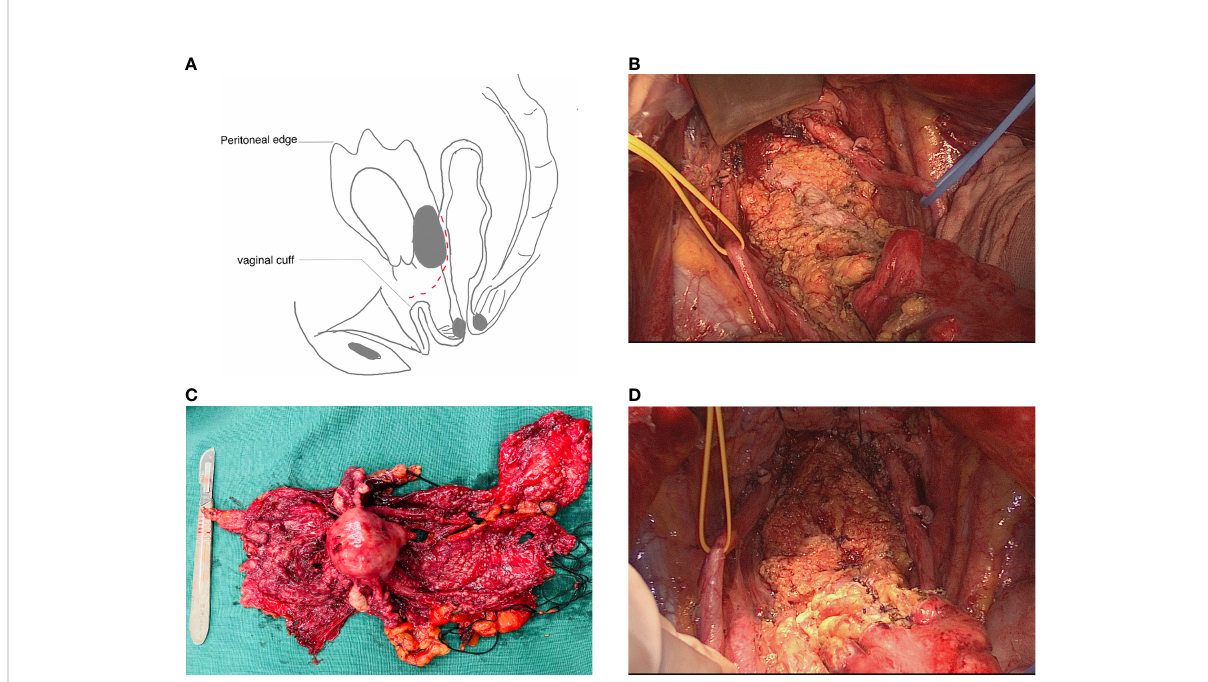
FIGURE 1 Rectosigmoid sparing en bloc pelvic resection for fi xed ovarian tumors. (A) Tumor attaching the intact specimen was left on the colon as the bottom of the false capsule. Cutting plane is shown as a dashed line. (B) Seromuscular defections (black arrow) after complete resection of implants on the rectosigmoid colon. (C) The whole specimen was removed intact with a false capsule. (D) Seromuscular layer was repaired with interrupted